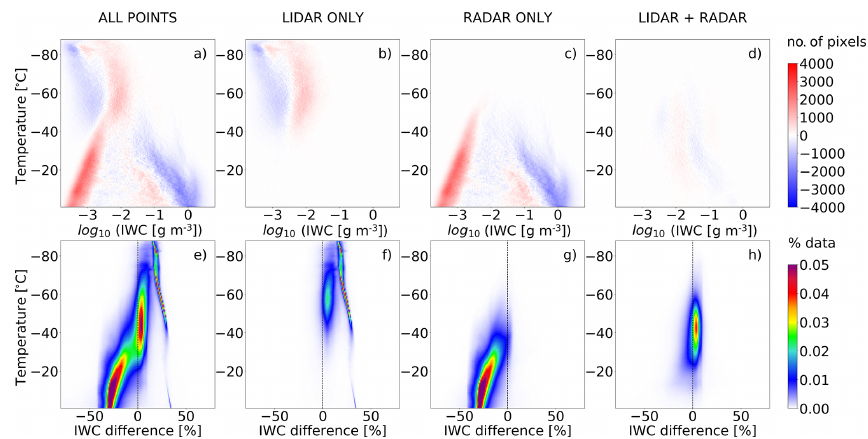
Figure 9. Comparison of the retrieved IWC for the two microphysical parameterizations presented in Sect. 3.2 (but with the same lidar ratio a priori). Panels (a) – (d) and (e–h) correspond to panels (e) – (h) and (i–l) of Fig. 8,